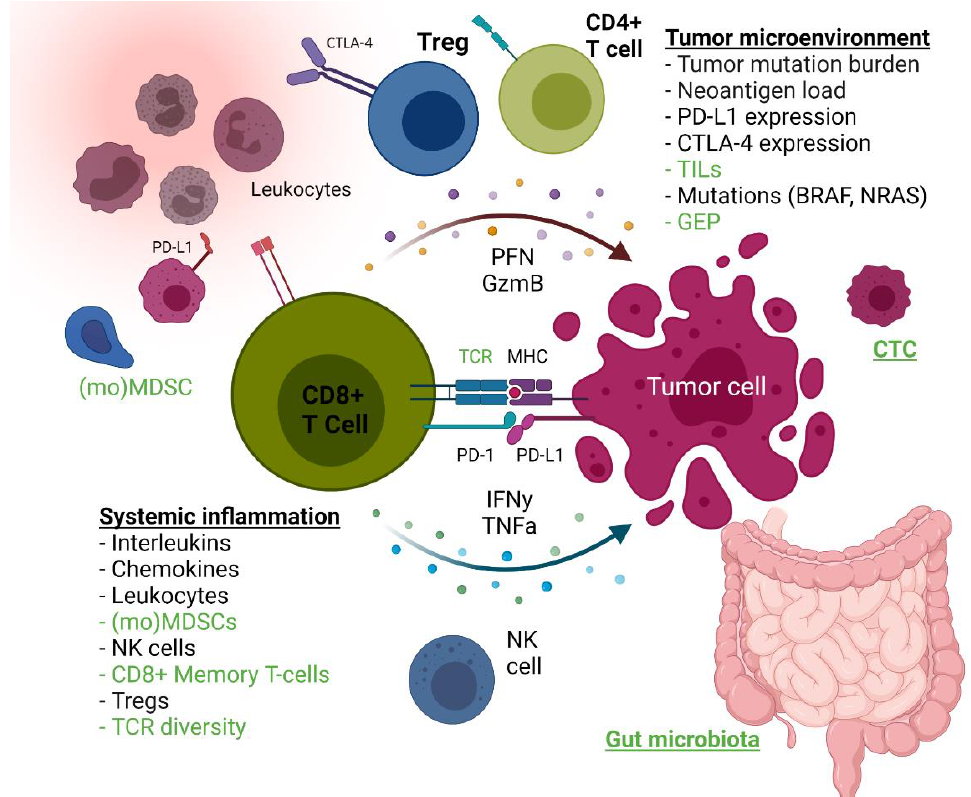
Figure 4. Overview of predictive biomarkers for response to ICIs. Biomarkers that were associated with response in most studies are marked green and biomarkers that were not associated with re- sponse in most studies are marked black. T cell infiltration markers, tumor cell microenvironment and gut microbiota. Abbreviations; CTC: circulating tumor cells, GzmB: Granzyme B, MDSCs: myeloid-derived suppressor cells, MHC: major histocompatibility complex, NK: natural killer, PFN: perforin, Tregs: regulatory T cells. Created with BioRender (BioRender.com, accessed on 24 November 2021).